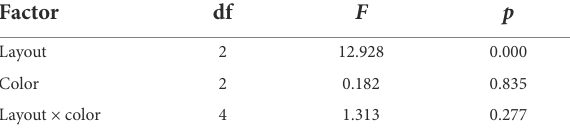
TABLE 12 Results of repeated measures ANOVA on saccade length.